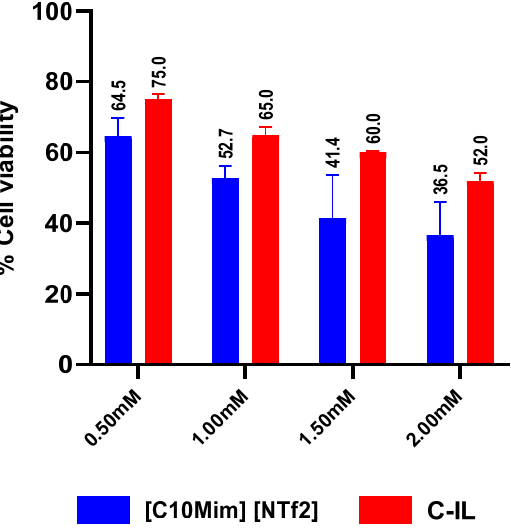
Figure 7. The cytotoxic effects of IL at different concentrations on human cells. Blue bars represent NTf2-based ionic liquid and red bars represent a commercial ionic liquid, i.e., IL 1-butyl-1- methylpyrrolidinium bis-(trifluoromethylsulfonyl)imide.